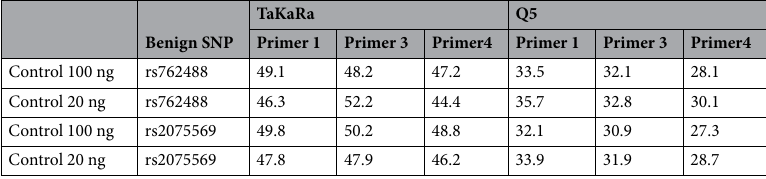
Fig. 1. Assessment of PCR conditions.